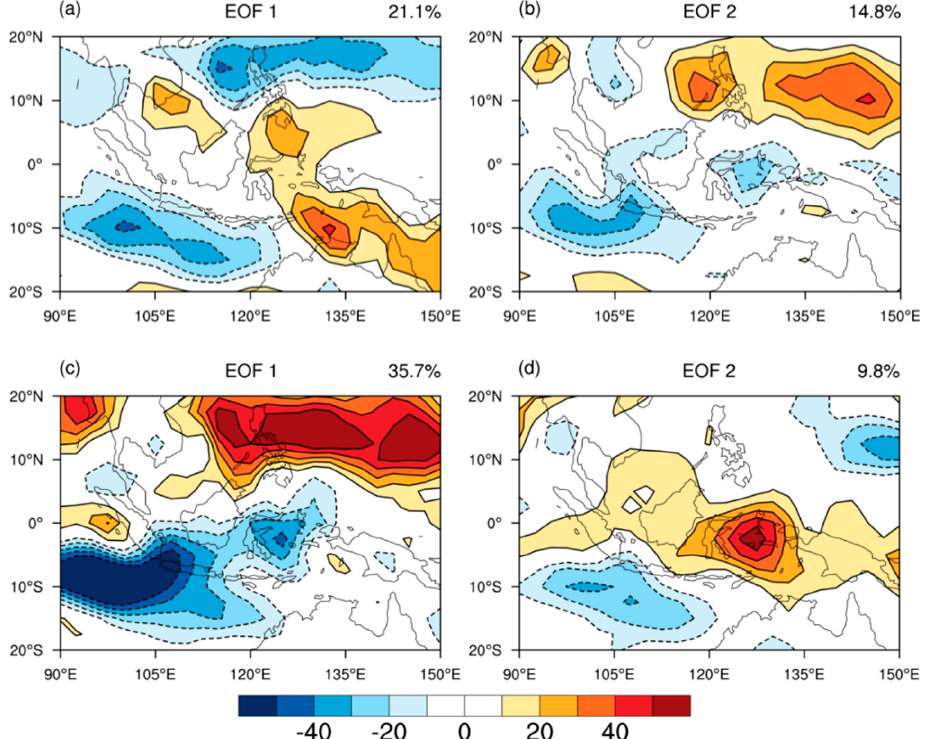
Q anomalies over 2